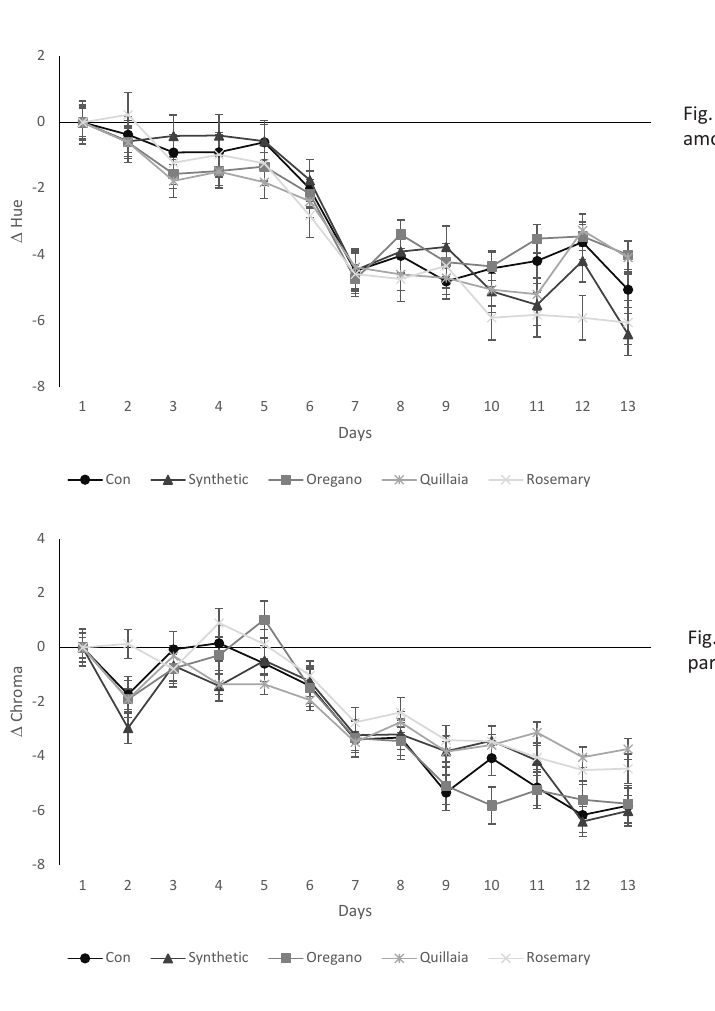
Fig. 1d. Variation of Hue (tone) parameter among 12 days of refrigeration at 4 °C